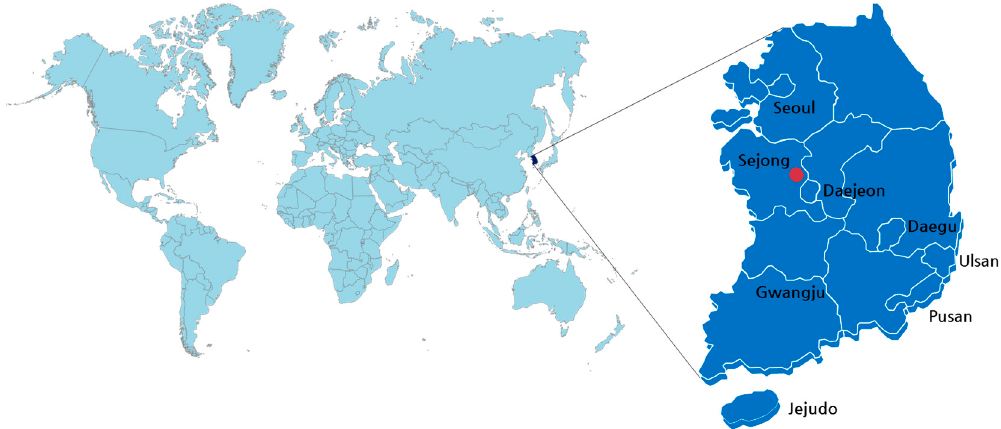
Figure 2. Location of Sejong City in South Korea.